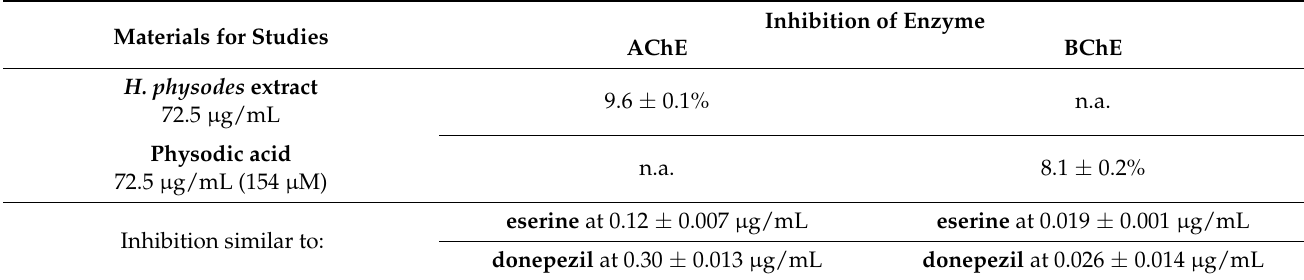
Table 3. Inhibition of acetylcholinesterase (AChE) and butyrylcholinesterase (BChE) by Hypogymnia physodes extract ( H. physodes extract) and physodic acid comparing with the reference substances. Materials for